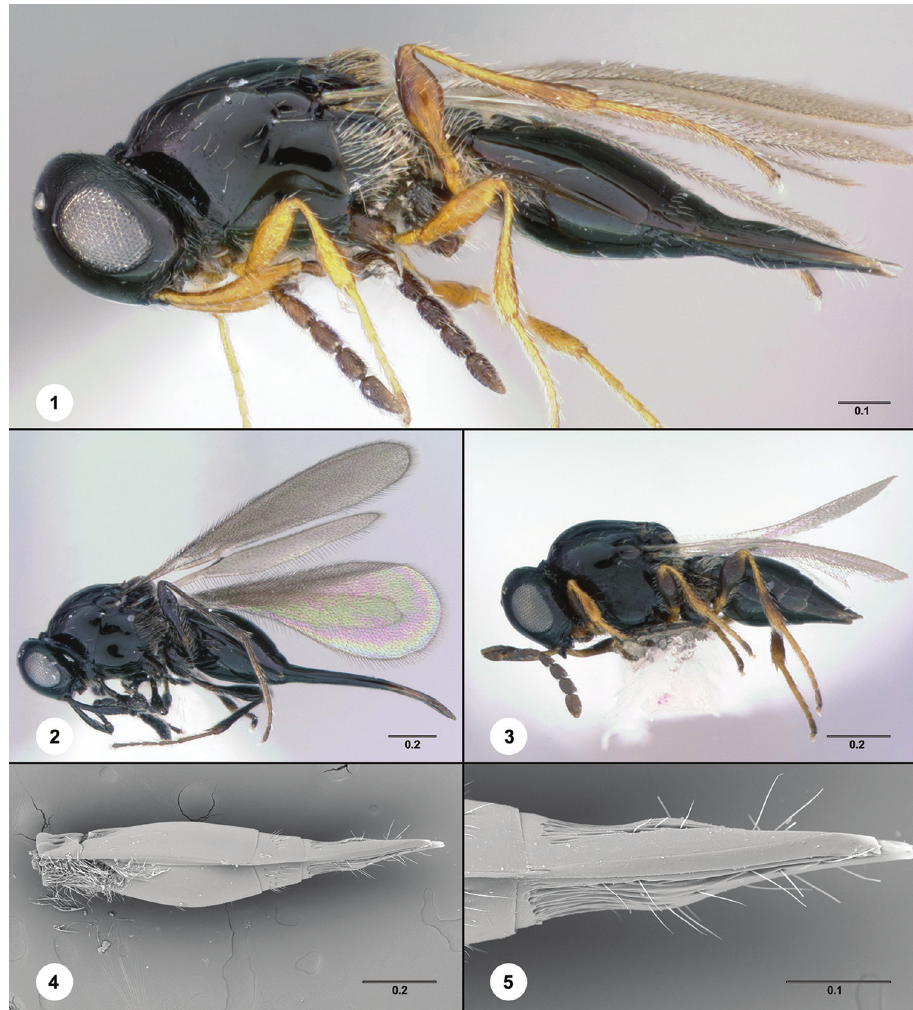
Figures 1–5. Metanopedias 1 female (OSUC 404924), habitus, lateral view 2 female (OSUC 265251), habitus, lateral view 3 female (OSUC 266113), habitus, lateral 4 female (USNMENT00989611_2), meta- soma, lateral view 5 female (USNMENT00989611_2), T5, S5, lateral view. Scale bars in